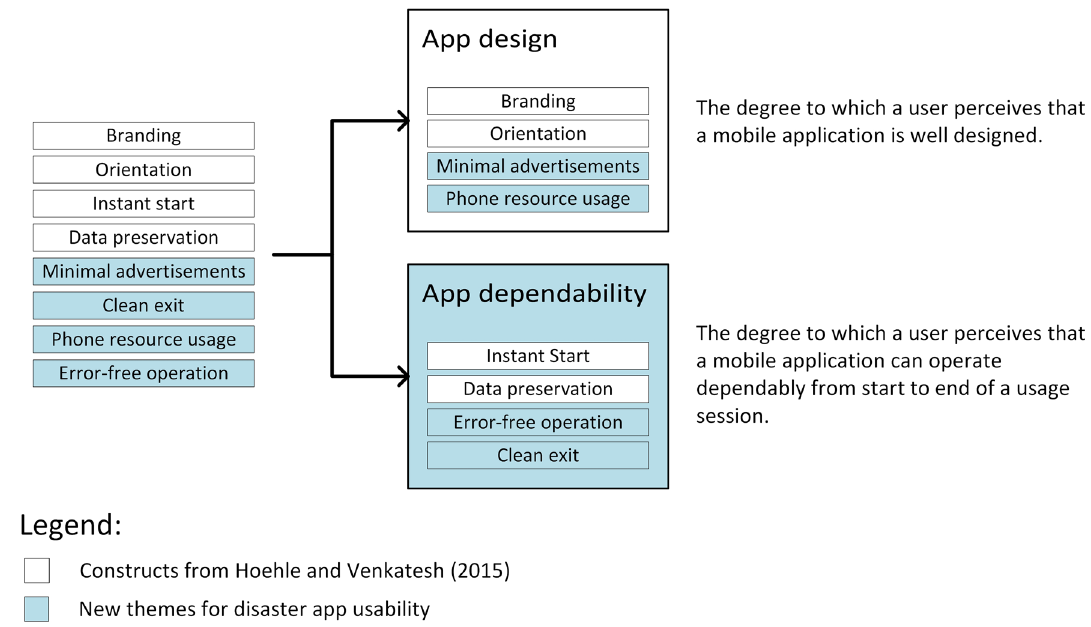
Fig. 5 Formation of ‘‘app dependability’’ and ‘‘app design’’ as two distinct thematic